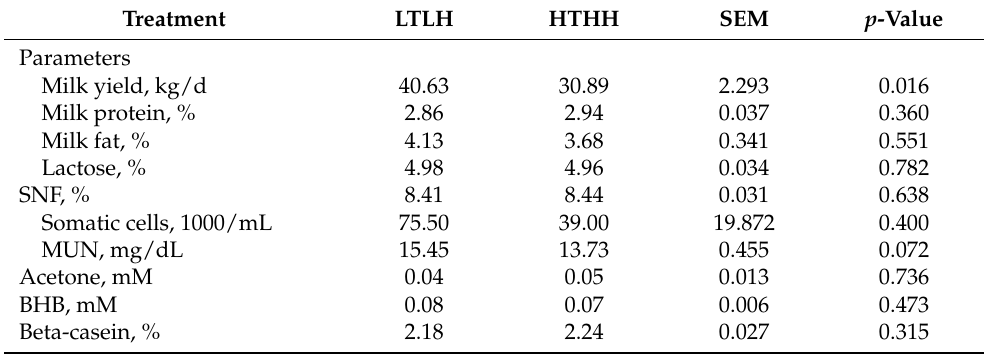
Table 6. Milk yield and characteristic in dairy cows exposed to two distinct environmental conditions.